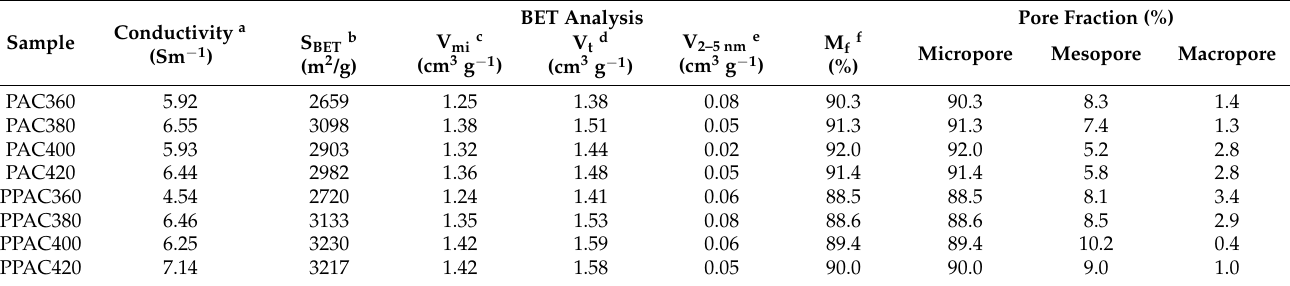
Table 2. BET analysis results and the electrical conductivity of activated carbon samples. Conductivity Sample